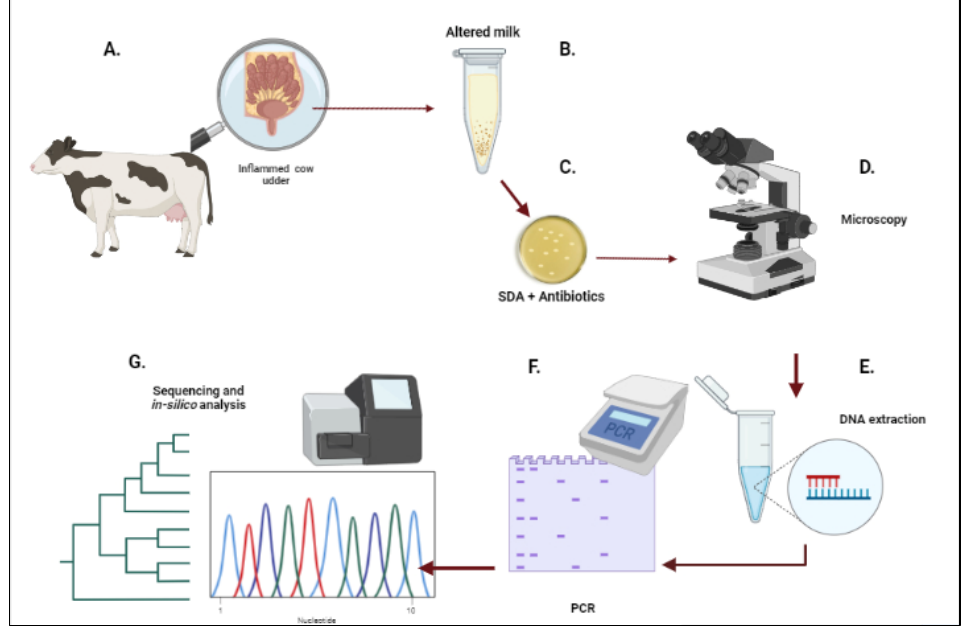
Figure 1. Overview of the methodology described in Materials and Methods. ( A ). Identification of the cow with chronic mastitis. ( B ). Sample collection of milk from the infected cow. ( C ). Microbiological culture of the milk sample on SDA supplemented with vancomycin (5 μ g/mL) and nalidixic acid (20 μ g/mL). ( D ). Microscopy of the samples with visible colony growth and selection of possible Prototheca colonies. ( E ). DNA extraction of the samples previously selected with microscopy. ( F ). Molecular identification with endpoint PCR of the cytB gene followed by electrophoresis. ( G ). Sequencing of the obtained amplicons (approx. 600 bp) to confirm the identification and in silico analysis of the Prototheca cytB sequences. The figure was created with BioRender.com.